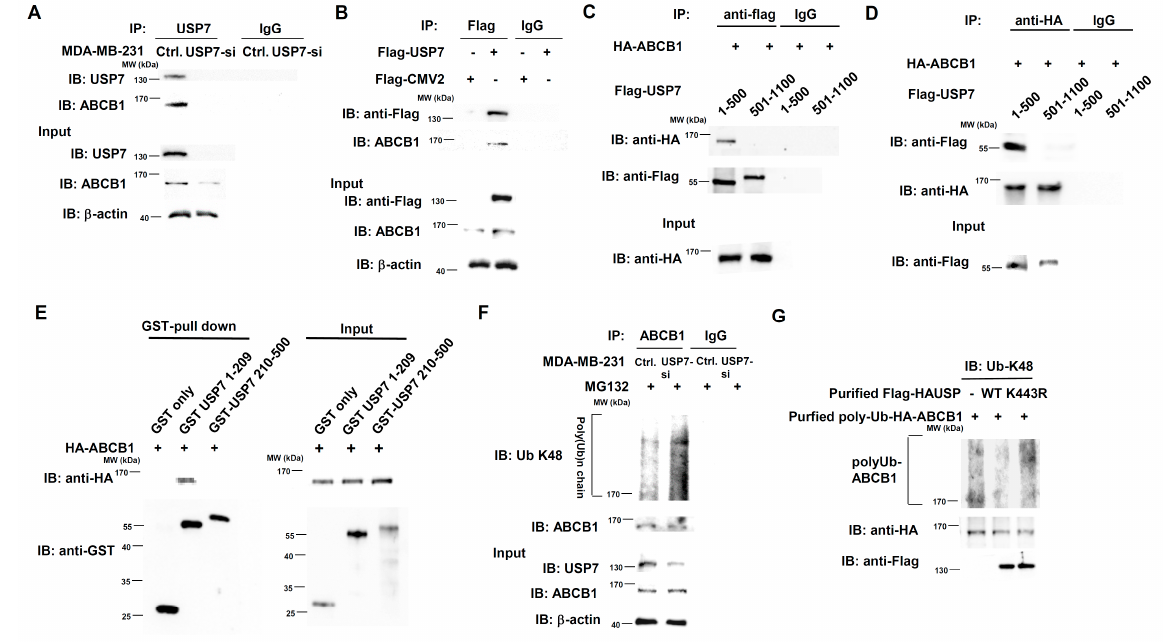
Figure 9. Direct regulation of ABCB1 stability by USP7. ( A ) Interaction between endogenous USP7 and endogenous ABCB1 in MDA-MB-231-USP7-silencing cells, assessed using co-immunoprecipi- tation assays. ( B ) Interaction between USP7 and ABCB1 in 293T cells with transient overexpression of Flag-tag USP7, assessed using co-immunoprecipitation assays. ( C ) Domain mapping of USP7 in- teraction with ABCB1, assessed using co-immunoprecipitation assays with anti-flag antibodies. ( D ) Domain mapping of USP7 interaction with ABCB1, assessed using co-immunoprecipitation assays with anti-HA antibodies. ( E ) Direct interaction of USP7 and ABCB1, assessed using GST-pull down assays. ( F ) Levels of K48-linked polyubiquitinated ABCB1 in MDA-MB-231-USP7-silencing cells un- der MG132 treatment, assessed using in vivo deubiquitination assays. ( G ) Effect of USP7 WT and K443R mutant on K48-linked polyubiquitinated ABCB1, assessed using in vitro deubiquitination